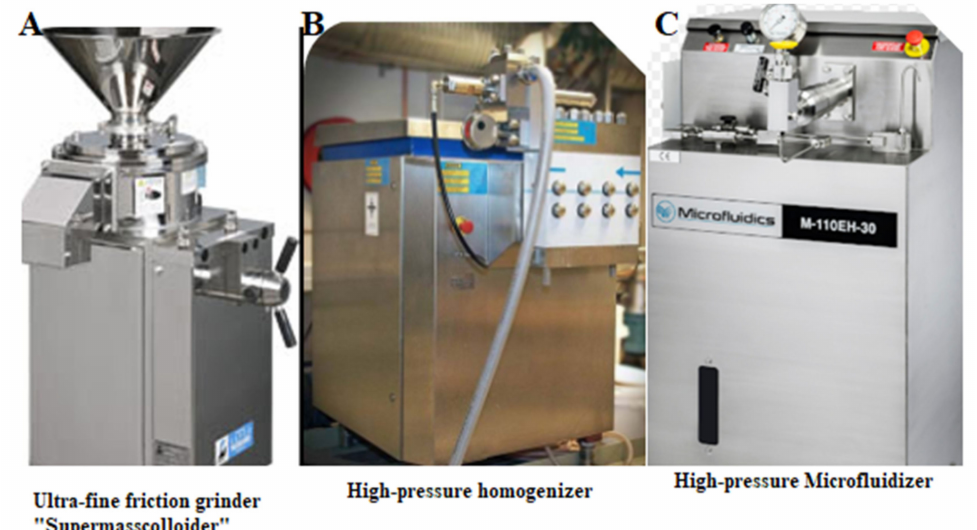
Figure 4. The three most common mechanical devices for the production of CNFs and LCNFs. ( A ) Ultrafine grinder, ( B ) high pressure homogenizer (HPH), and ( C ) high pressure microfluidizer